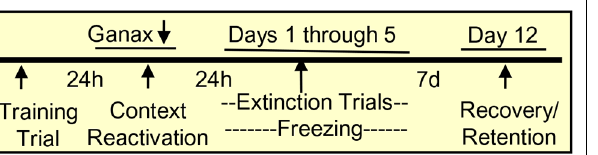
ganaxolone or vehicle was administered just once, immediately after the first session in which the mice were reexposed to the con- text in which fear conditioning was performed the day before